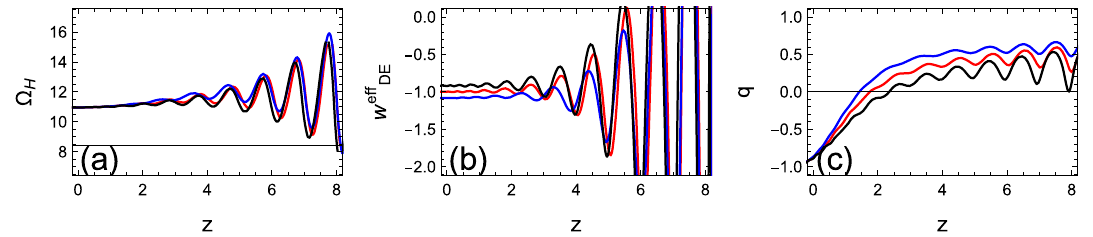
(middle) with and DE